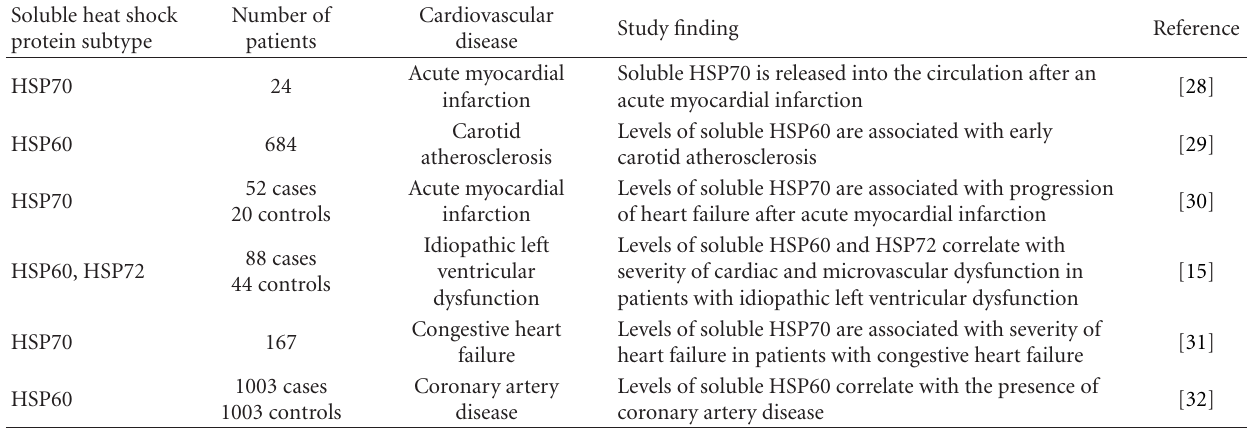
Table 3: Soluble heat shock proteins and their association with cardiovascular